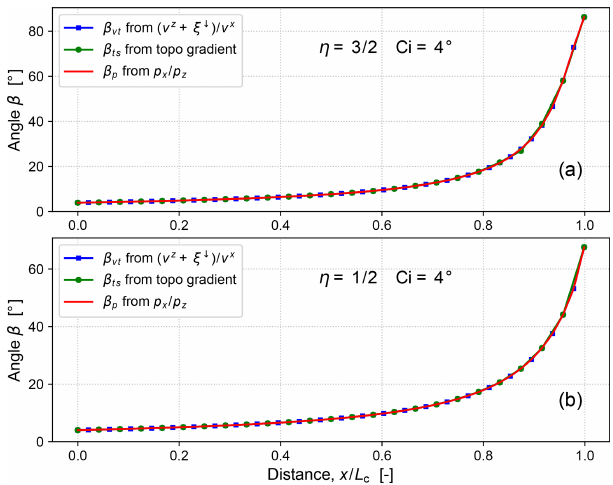
Figure 10. Estimation of the surface-normal angle from vertical β , i.e. the angle of the surface from horizontal for (a) η = 3 (b) η = 1 and with µ/η = 1 and Ci = 4 ◦ . This angle can be com- 2 2 puted in three ways; their mutual consistency shown here provides a partial validation of the ray-tracing